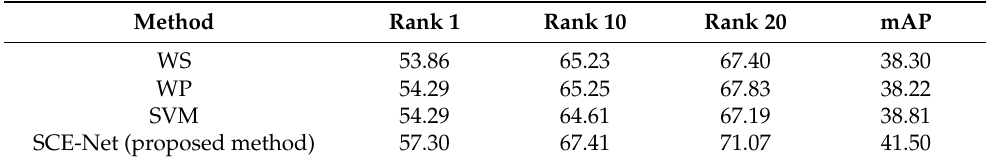
Table 9. Comparisons of ReID accuracies of the proposed method and various score-level fusions with SYSU-MM01 (unit: %).